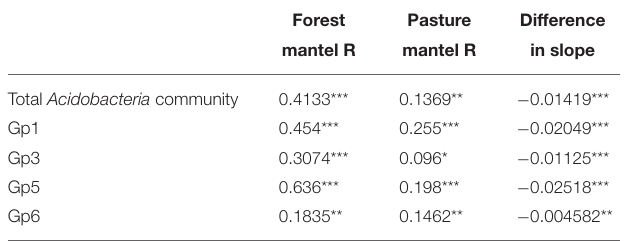
TABLE 3 | Correlations of taxonomic similarity (Bray Curtis) and geographic distance of phylum Acidobacteria and subgroups with comparison of slope of linear model between land use types. Forest Pasture Difference mantel R mantel